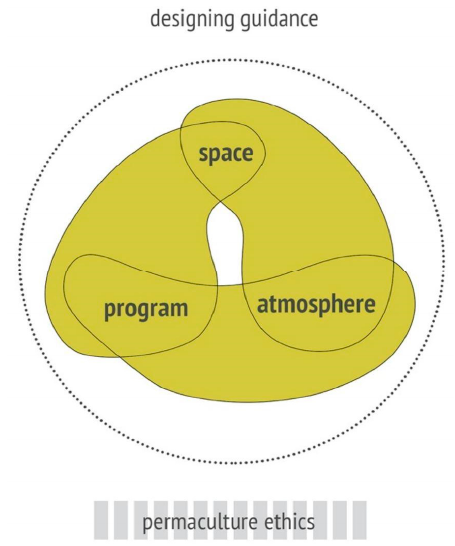
Figure 3. The concept of landscape design (Source: compiled by the author).